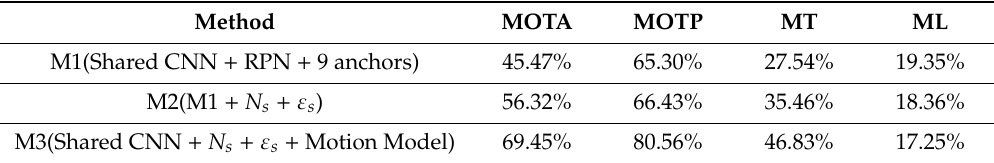
Table1. AnalysisoftheO ffl Table 1. Analysis of the Offline Candidates Recommendation and Motion Model using the KITTI dataset.